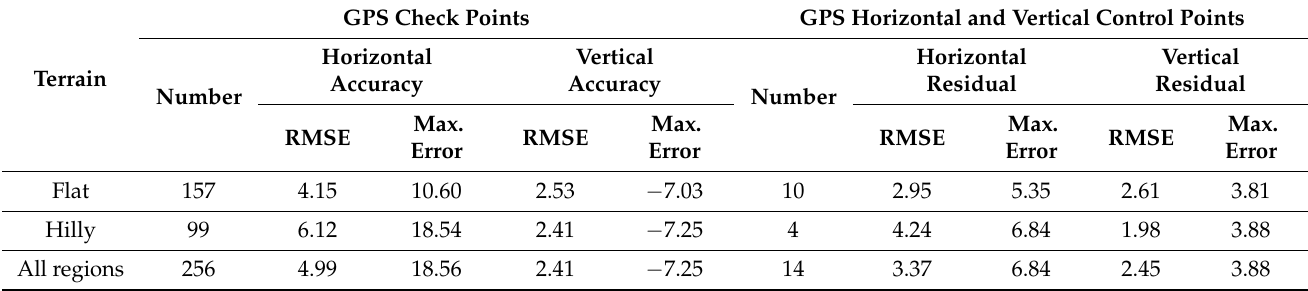
Table 11. Experimental results of integrated processing of ZY3 experimental data (second